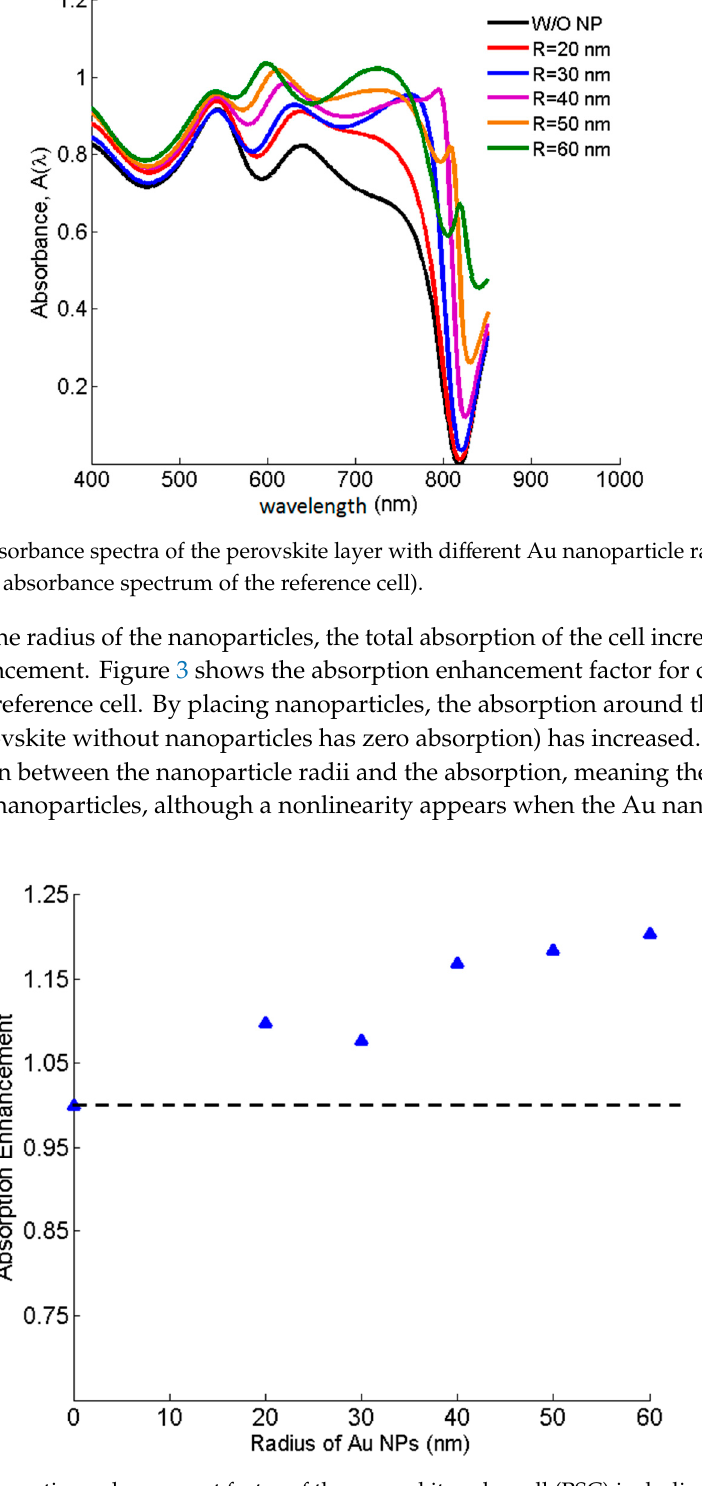
Figure 3. The absorption enhancement factor of the perovskite solar cell (PSC) including a plasmonic NP with different radii.